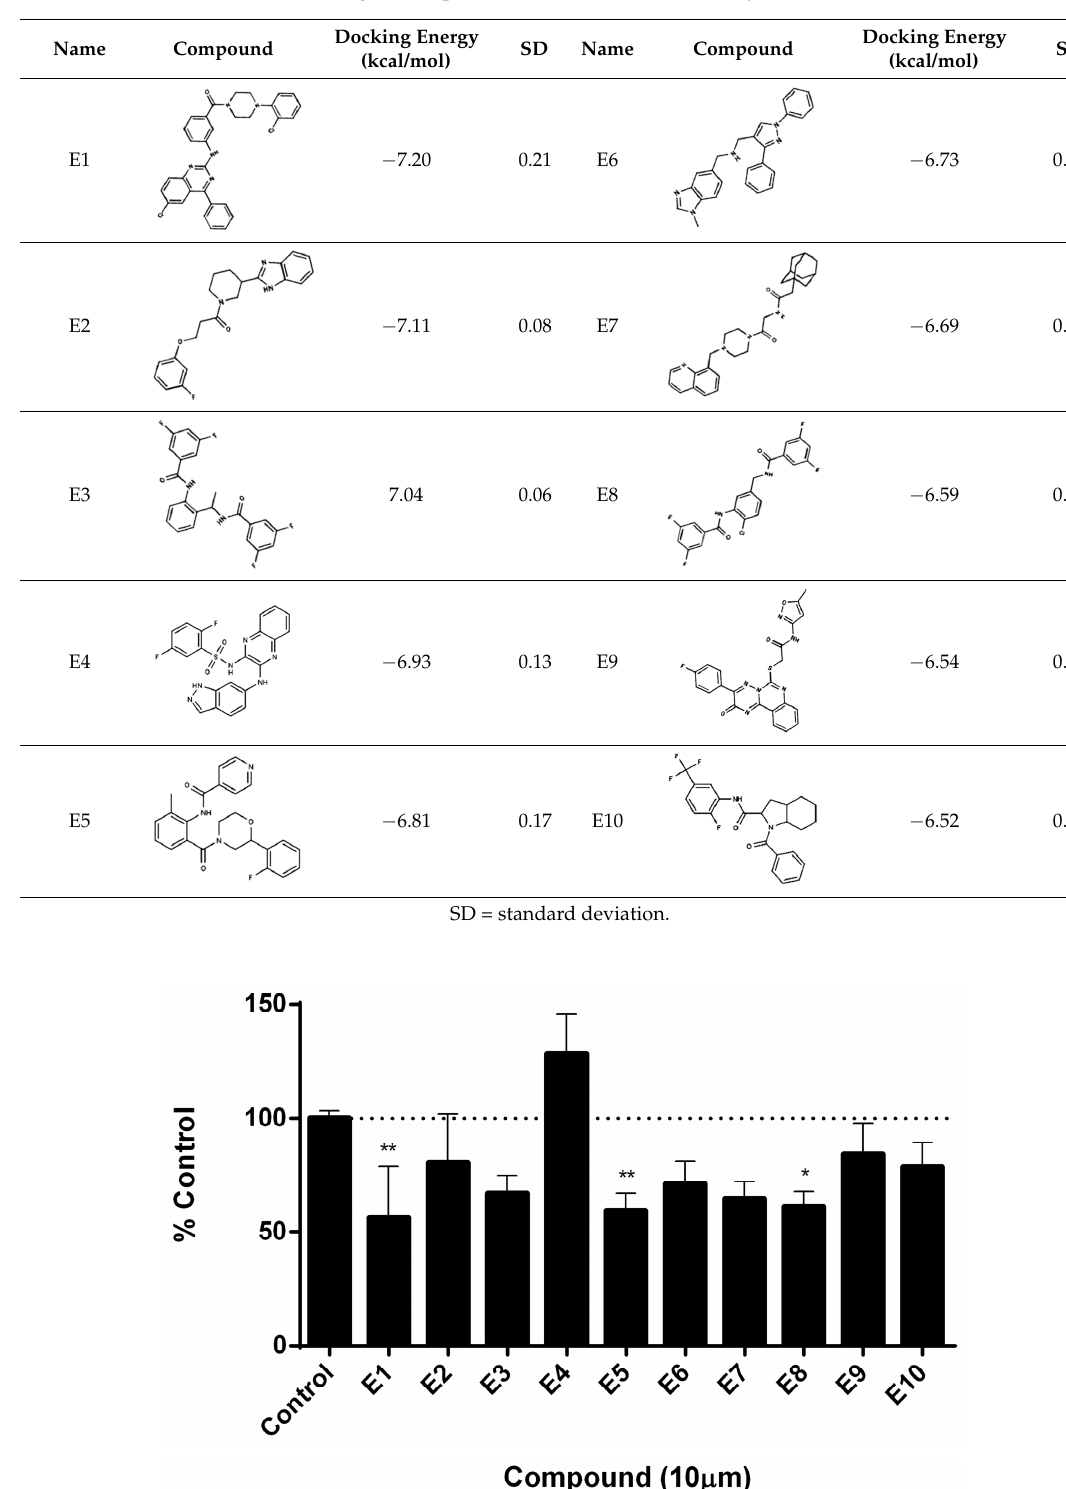
Figure 9. Spatial arrangement of the resulting compounds in the hDKC1 3D structure model. hDKC1 is colored in beige Residue K314 is indicated in blue, the PUA domain is colored in dark gray and Pocket 13 is highlighted in red. ( A ) E1; ( B ) E5; ( C ) E8. 4. Materials and Methods 4.1. Sequence Obtaining and Physicochemical Parameters Analysis of hDKC1 The aa sequence was obtained from the Universe Protein Resource (UniProt) (available online: http://www.uniprot.org/). The physicochemical parameters of the protein were generated from the ProtParam tool (available online: http://web.expasy.org/protparam/) using the ExPAsy server.